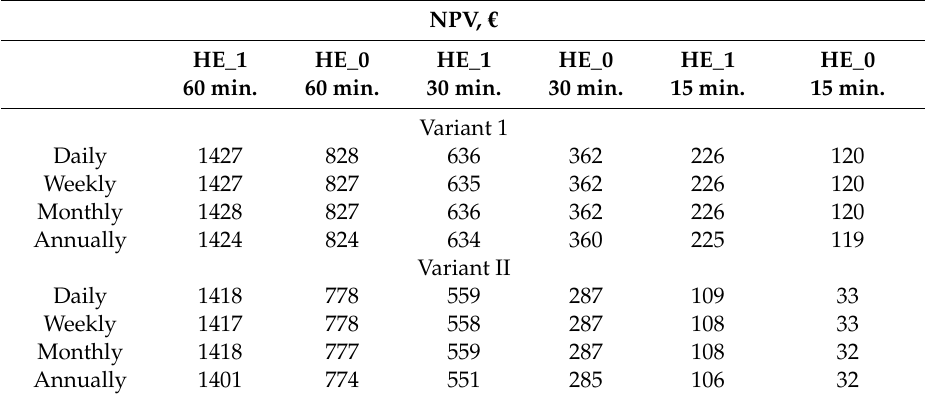
Table 3. Results of net present value (NPV) analysis for Scenario A.